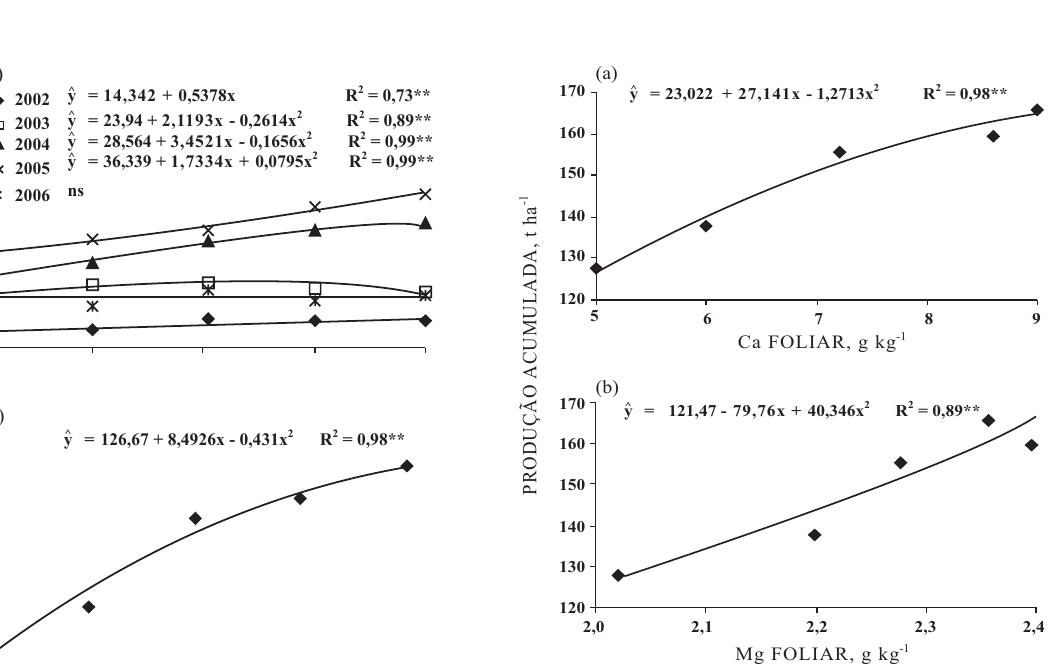
Figura 6. Relação entre os teores foliares de cálcio (a) e magnésio (b) e produção acumulada de frutos de goiabeiras nas safras de 2002 a 2006. Os pontos são médias de quatro repetições em cada ano.